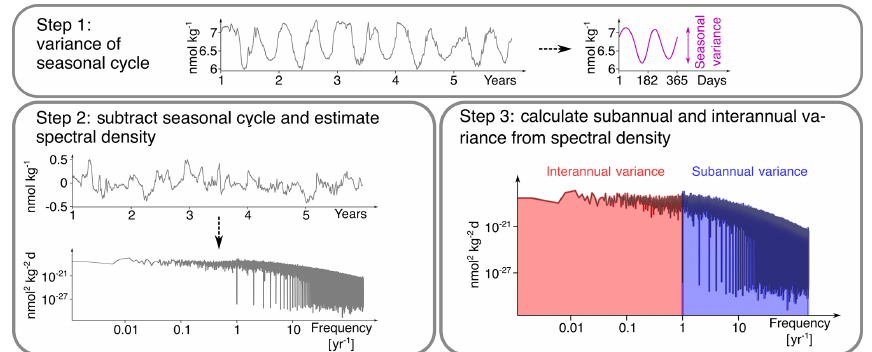
Figure 2. The three-step decomposition of [H + ] variance into interannual, seasonal, and subannual variance, exemplified for a surface grid cell at 40 ◦ N and 30 ◦ W in the North Atlantic in the preindustrial control simulation. In a first step, the climatological seasonal cycle is determined (over the whole period, only 5 years are depicted here) and its variance is calculated. Note that the seasonal cycle in this grid cell has two minima and maxima. In a second step, the spectral density of the anomalies with respect to the seasonal cycle is calculated. In a third step, interannual and subannual variance is estimated from the spectral